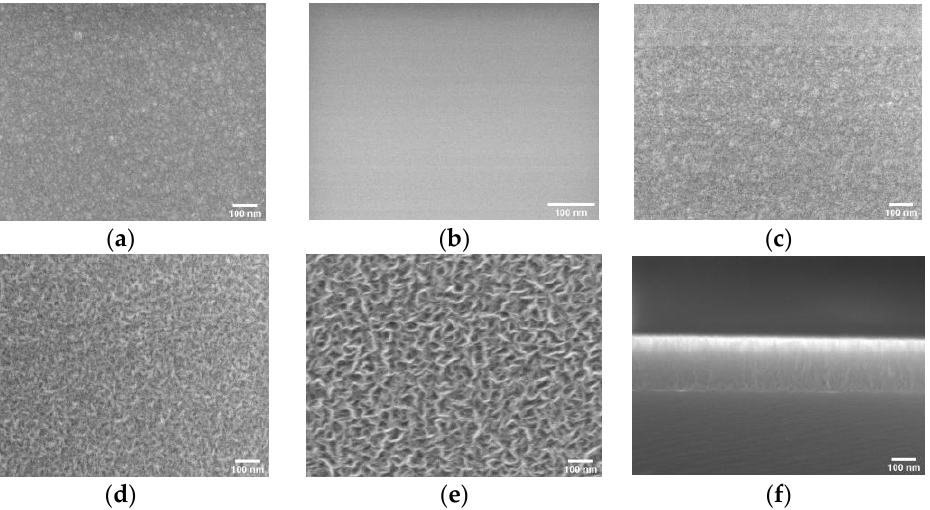
Figure 2. The typical SEM images for ( a ) LPCVD film and ( b ) PECVD films (T dep = 373–473 K). SEM images of PECVD films deposited at different temperatures: ( c ) 523 K, ( d ) 573 K, ( e ) 673 K. ( f ) Cross-section image of BC x N y /Si(100) structure, T dep = 673 K. Figure 3a–c shows the AFM images of the surface of the LPCVD films. The root- mean-square (RMS) roughness of films deposited at 673, 873, and 973 K is 0.21, 1.33, and 1.54, respectively. The PECVD film obtained at T dep = 523 K has RMS equal to 1.64 nm (Figure 3d). The data indicates the formation of smooth films.